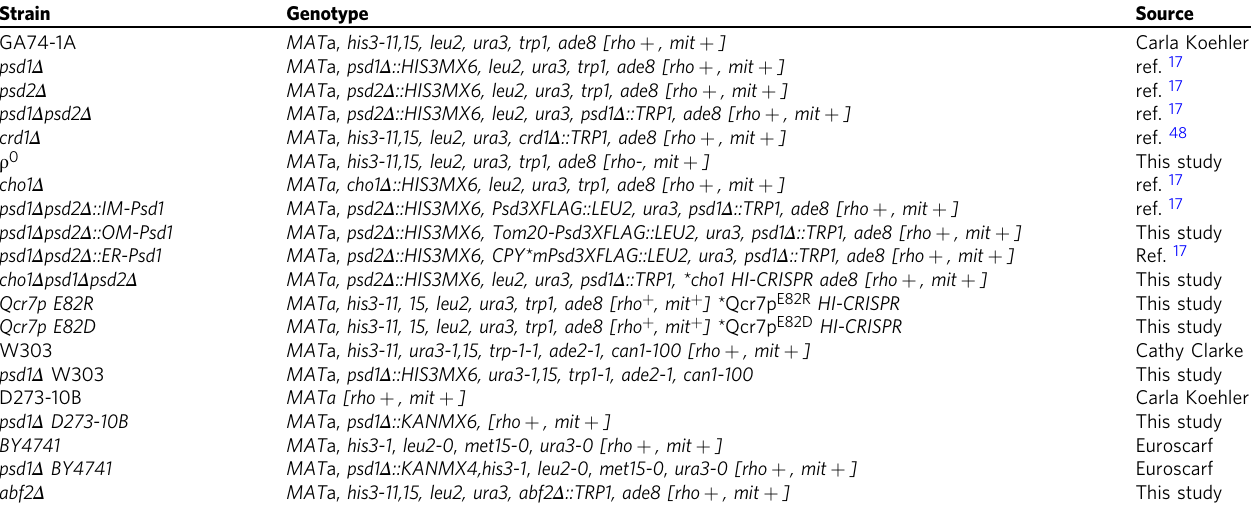
Table 1 Yeast strains used in this work. The names, genotypes, and sources of the yeast strains used in the present study